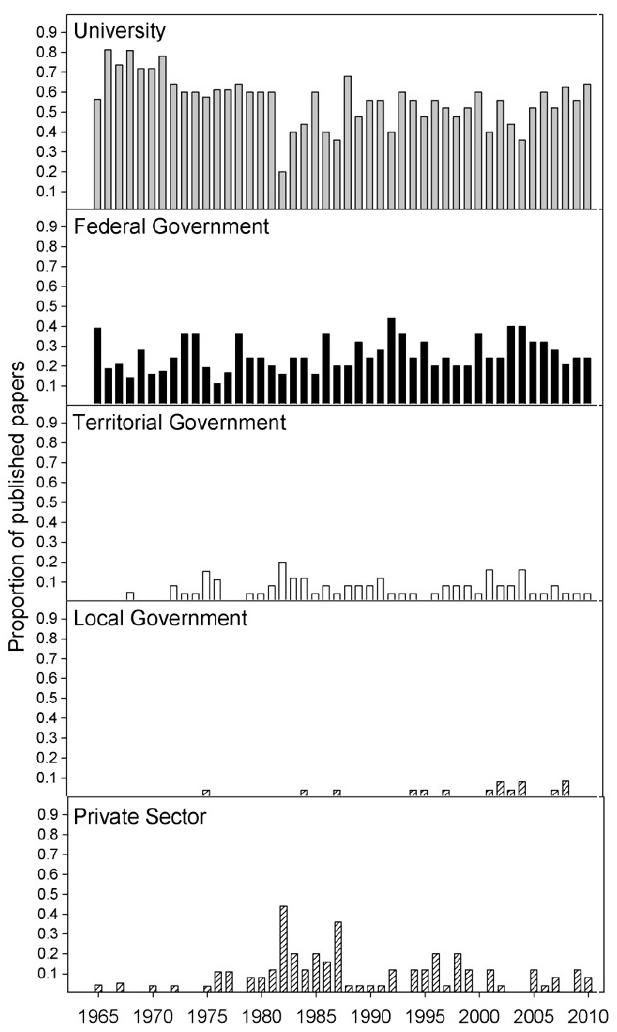
Fig. 4 . The disciplinary and subcategory composition of